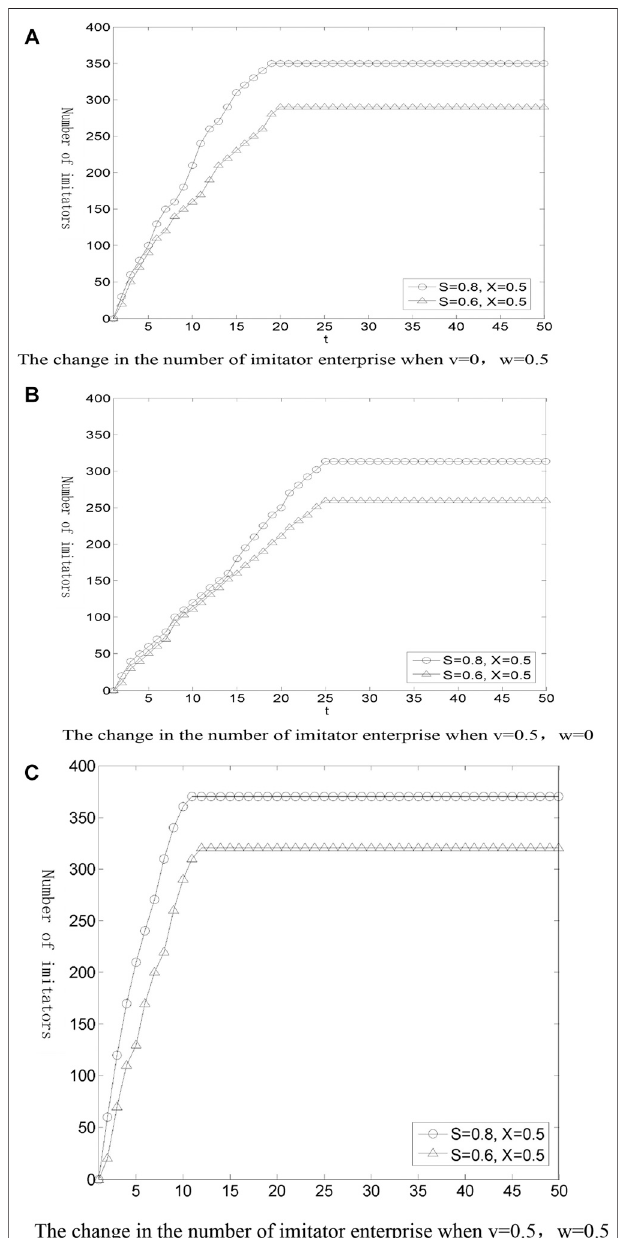
FIGURE2| In fl uenceofthedifferencebetweentheexpectedutilitySand the actual utility X of the imitator enterprise on the number of imitator enterprises. (A) The change in the number of imitator enterprise when v (cid:2) 0, w (cid:2) 0.5. (B) The change in the number of imitator enterprise when v (cid:2) 0.5, w (cid:2) 0. (C) The change in the number of imitator enterprise when v (cid:2) 0.5, w (cid:2) 0.5.